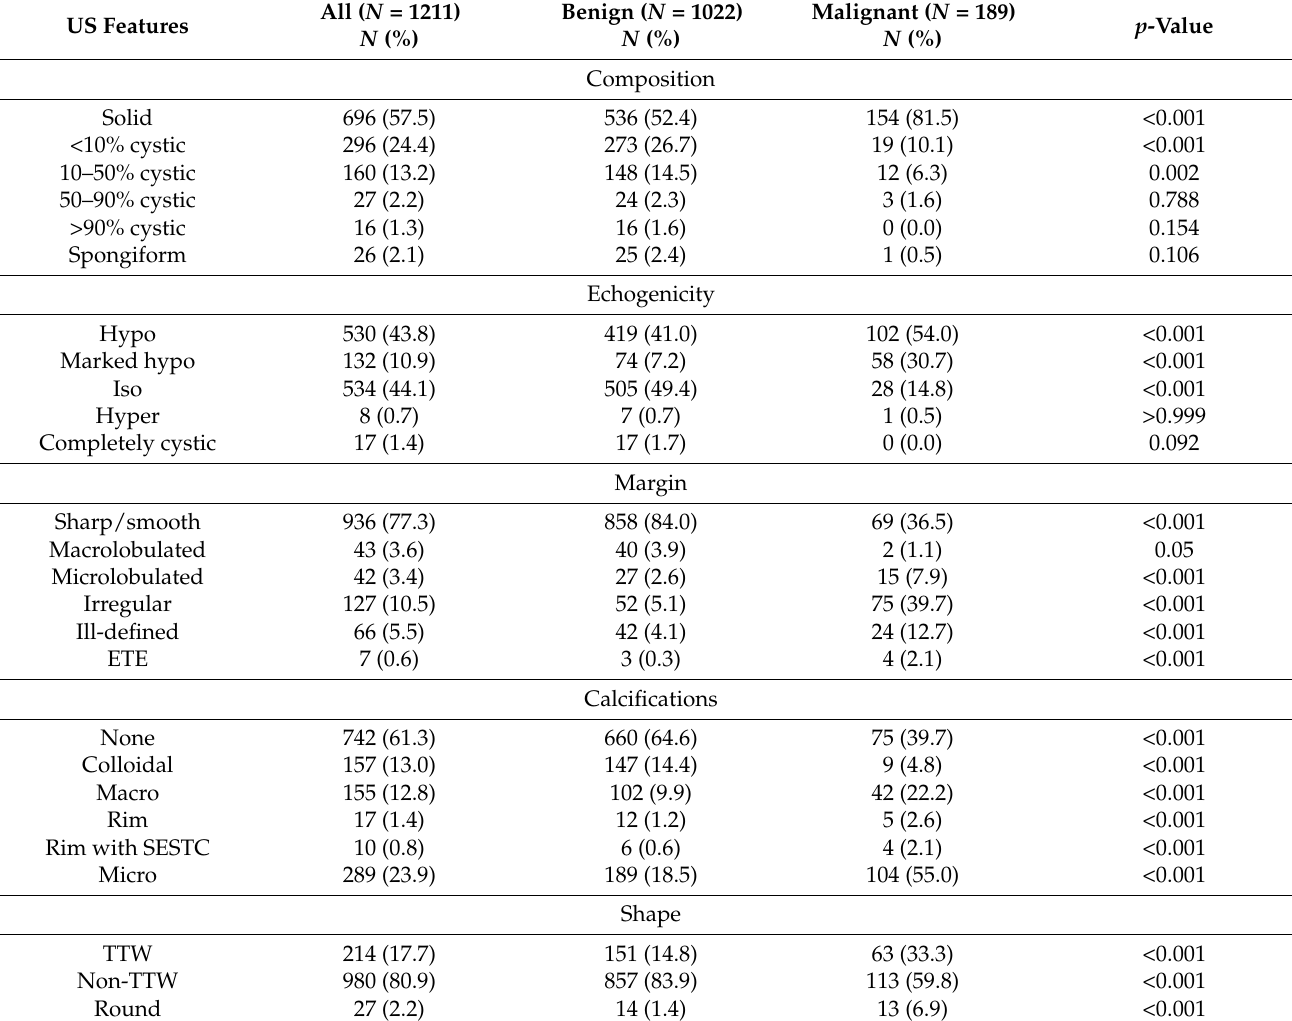
Table 3. Ultrasound (US) features in relation to cytological and histopathological